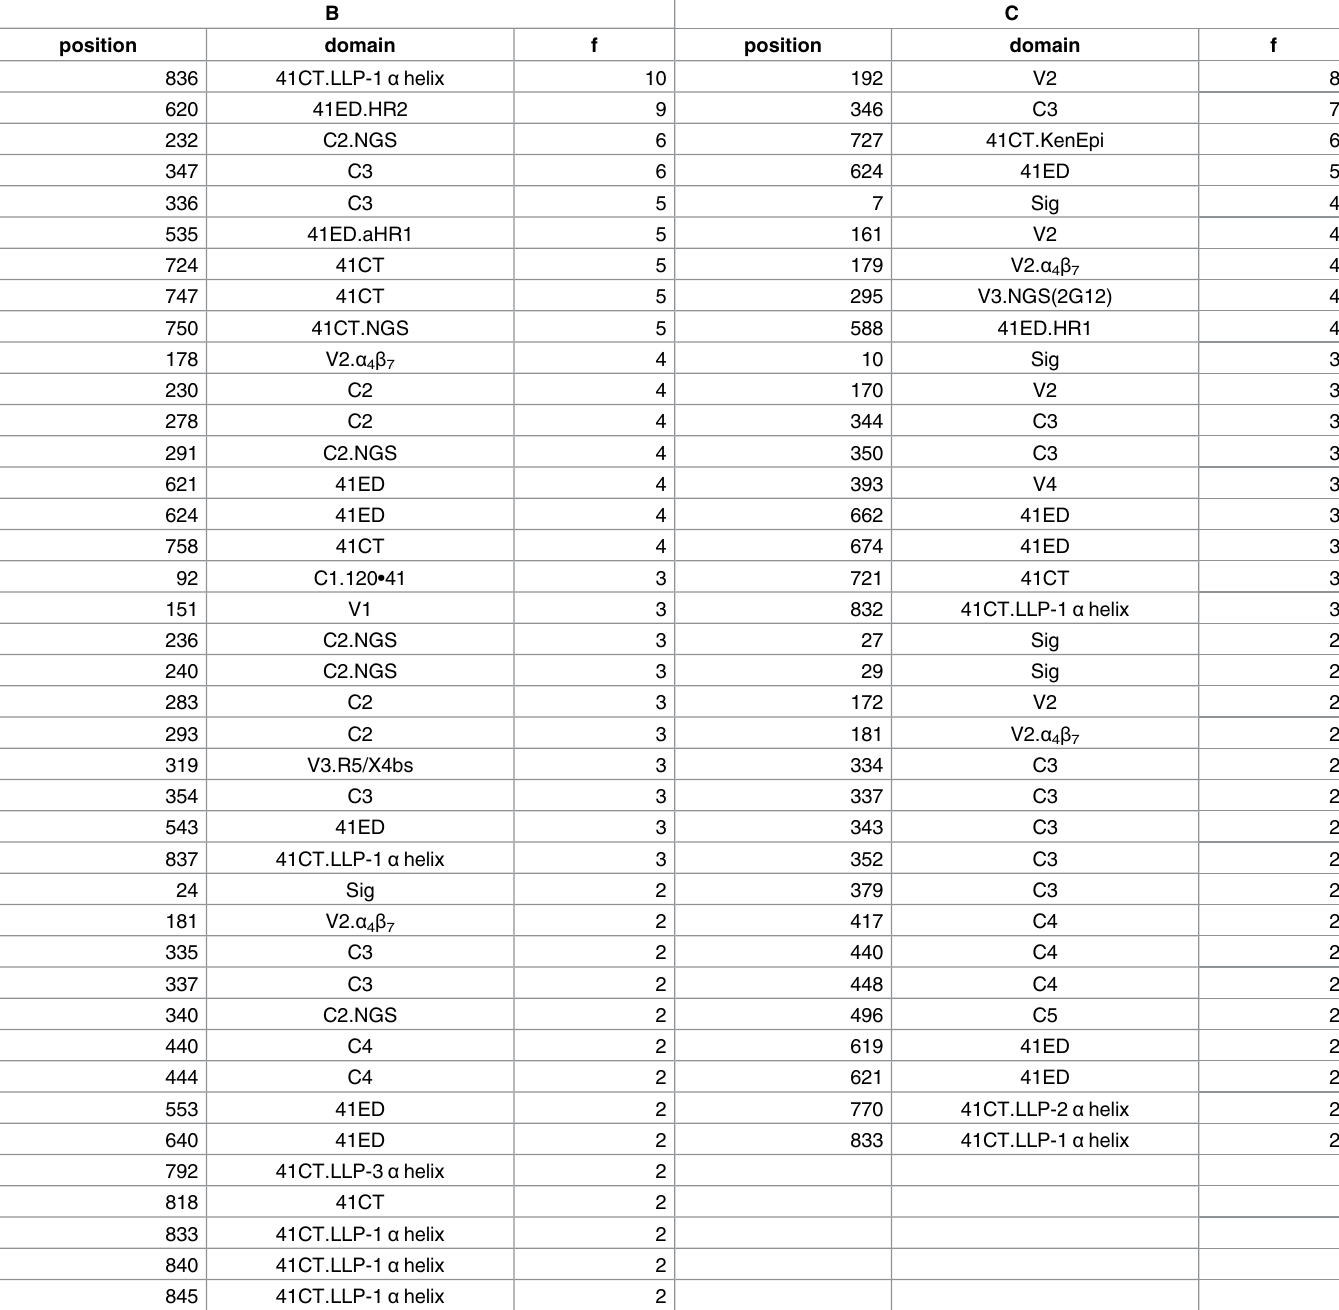
Table 2. Single AA in optimal networks determined on Founders, which appear at least 2 times (frequency f). The regionof Env is denotedahead of a decimalpoint, and any recognisedmotif after the